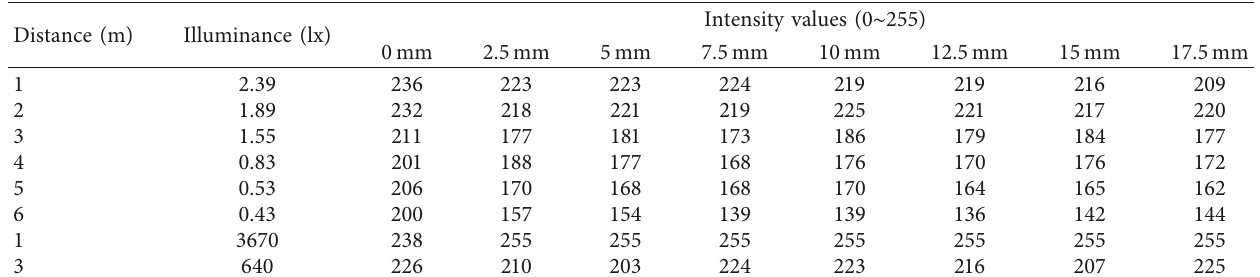
Figure 5: Experimental setup for (a) direct and (b) indirect lighting. Table 2: Illuminance level depending on distance.